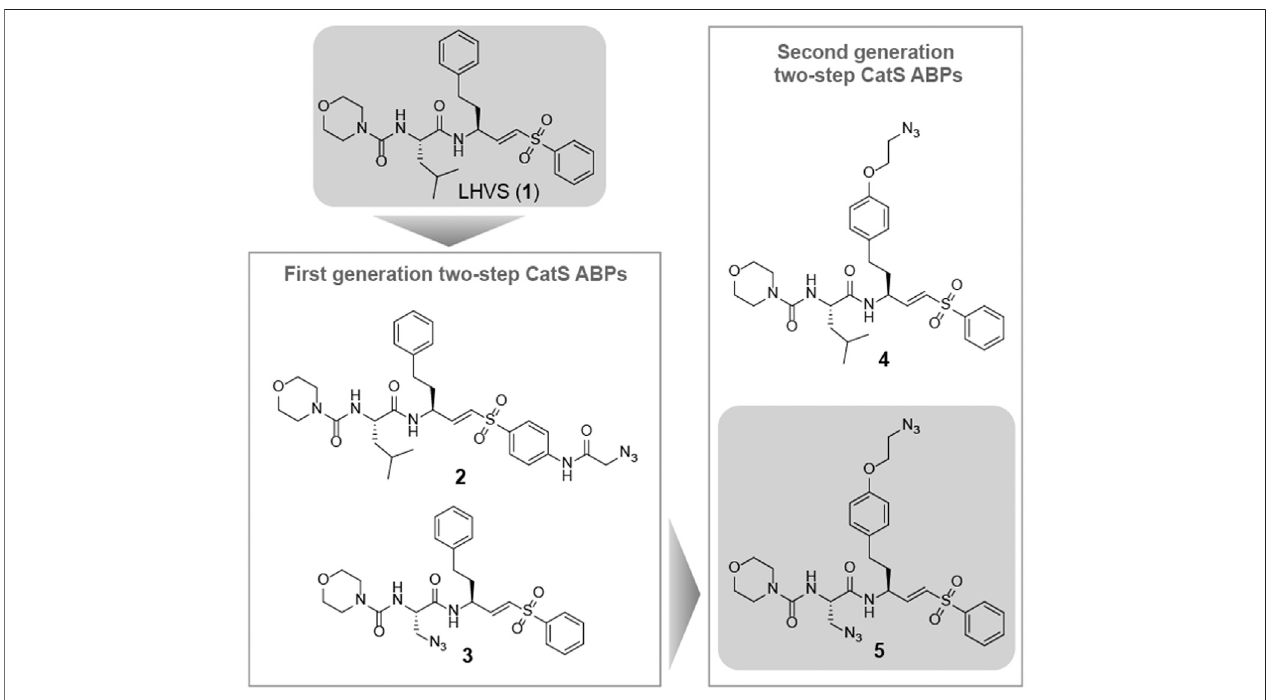
FIGURE 1 | Structures of the reported Cat S selective inhibitor LHVS (1) and the fi rst and second generation LHVS-derived two-step ABPs.